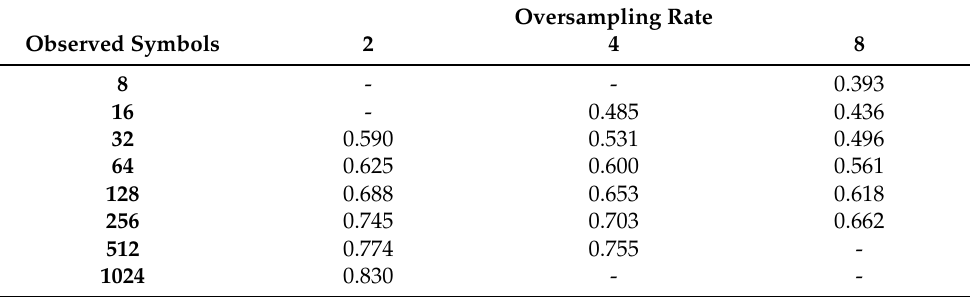
Table 5. PCC of observed symbols for networks trained on 1024